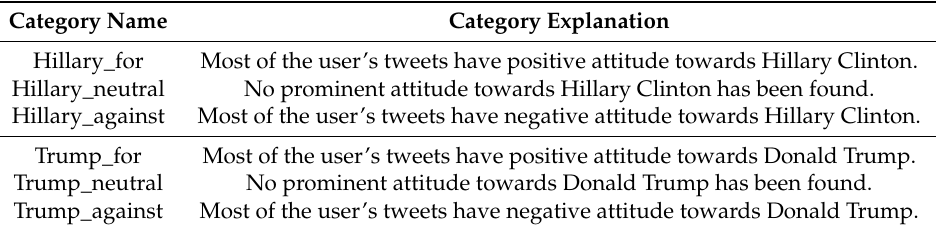
Table 1. The categories for twitter user sentiment